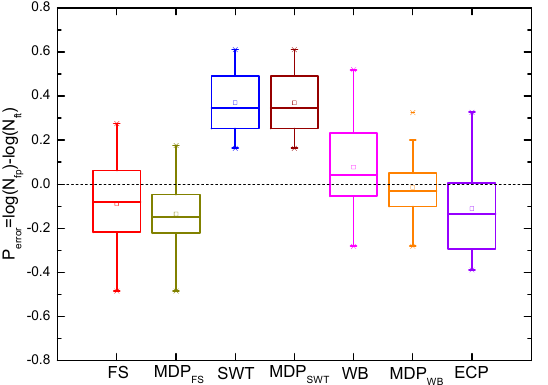
Figure 8. Box plot of model prediction errors for GH4169 under multiaxial loading at 650 °C.